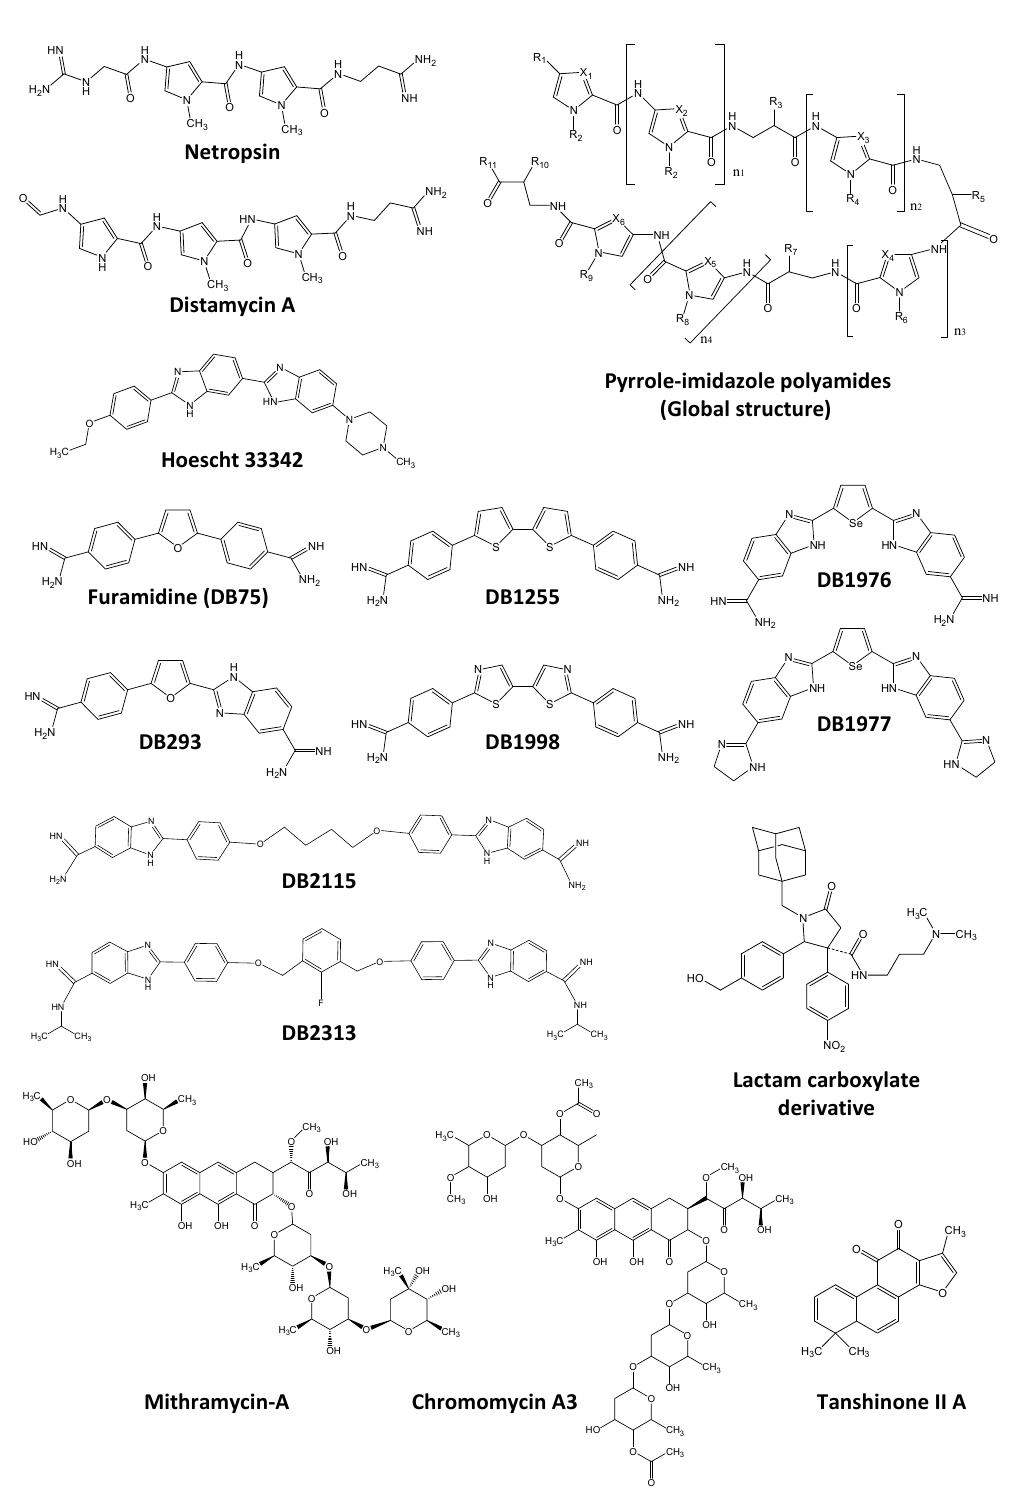
Figure 9. Minor groove DNA binding drugs as inhibitors of transcription factors/DNA binding.